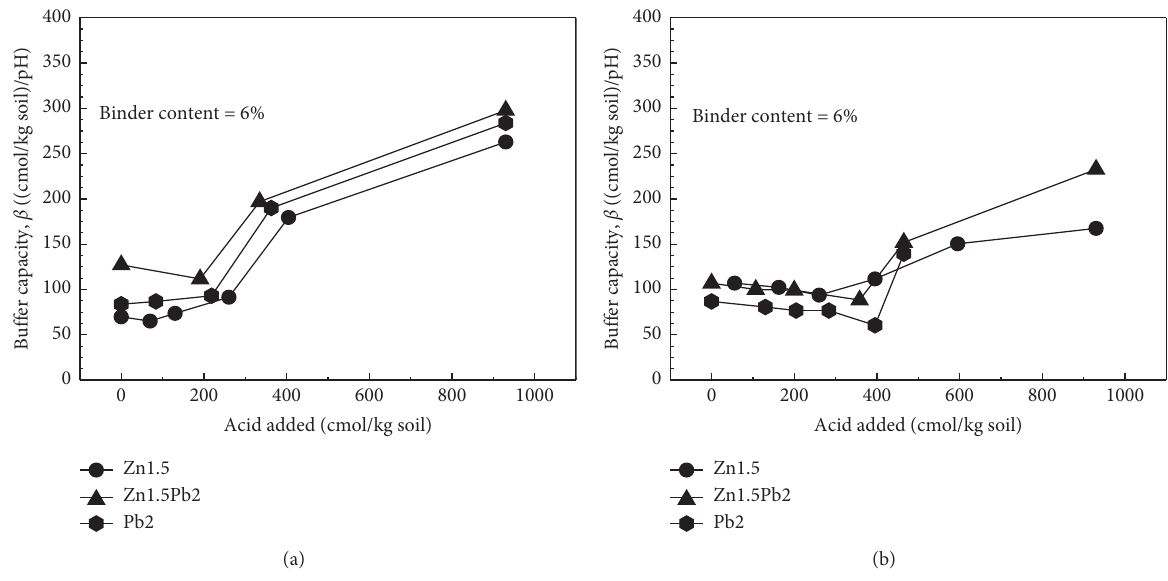
Figure 2: Buffer capacity ( β ) of the stabilized contaminated soils cured for 28d: (a) KMP binder; (b) PC